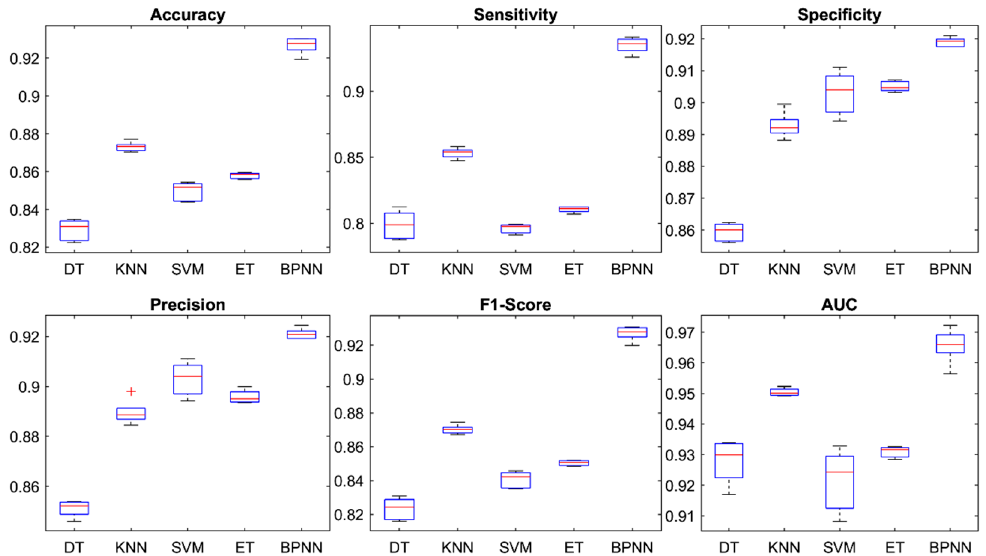
Figure 14. First stage classification: Box-plot distributions of mean performance measurements for five alternative classifiers using repeated random trials.